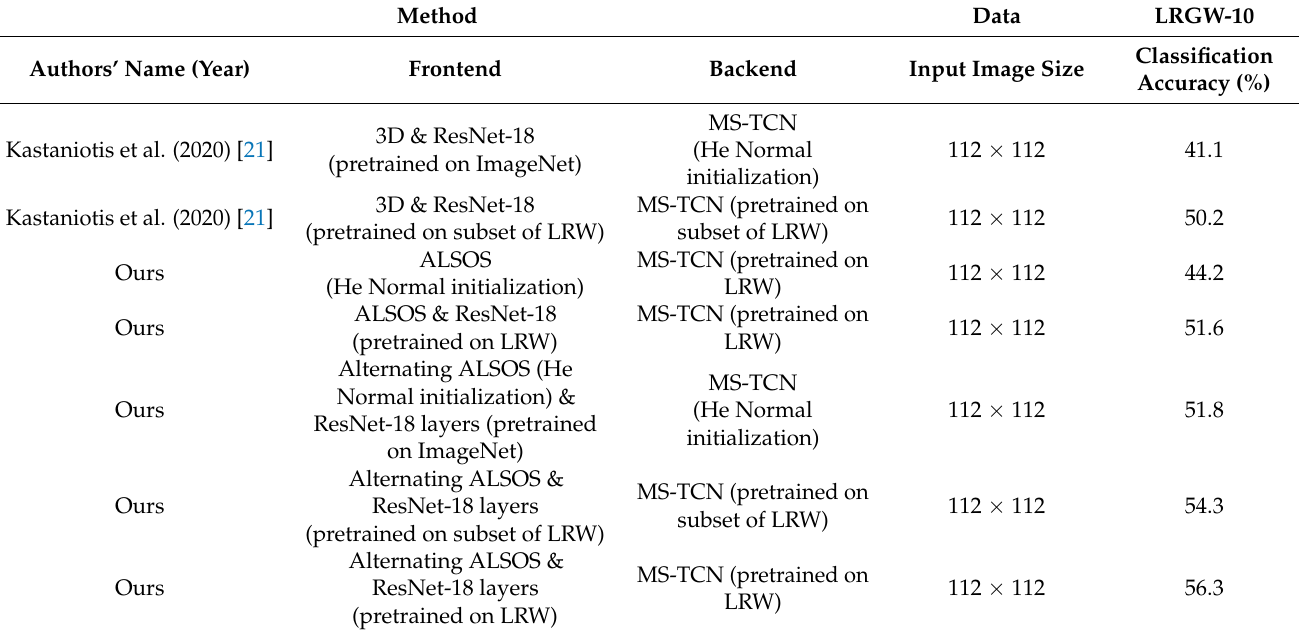
Table 2. Classification Results on the LRGW-10 medical oriented